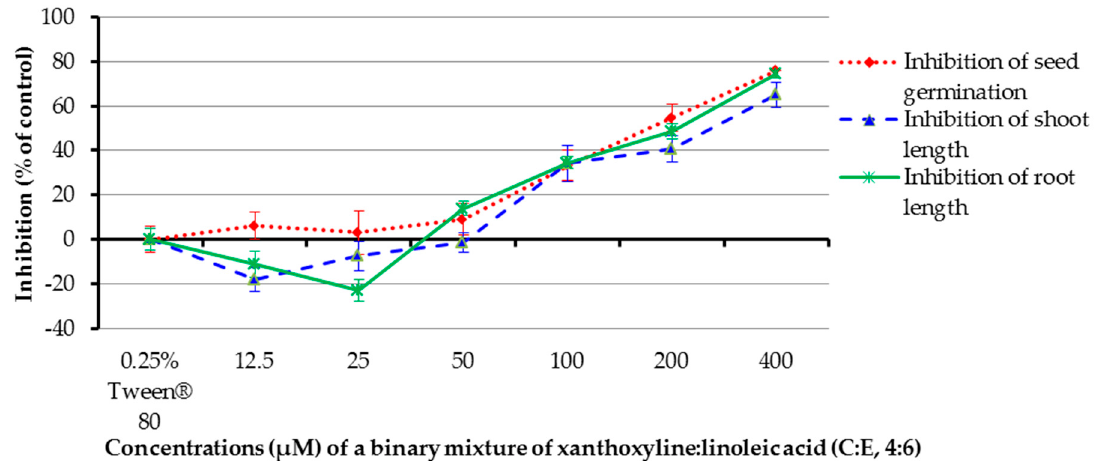
Figure 9. Inhibitory effects of a binary mixture of xanthoxyline:linoleic aicd (4:6) on seed germination and shoot and root growth of Chinese amaranth. A 0.25% aqueous solution of Tween ® 80 was used as a control.